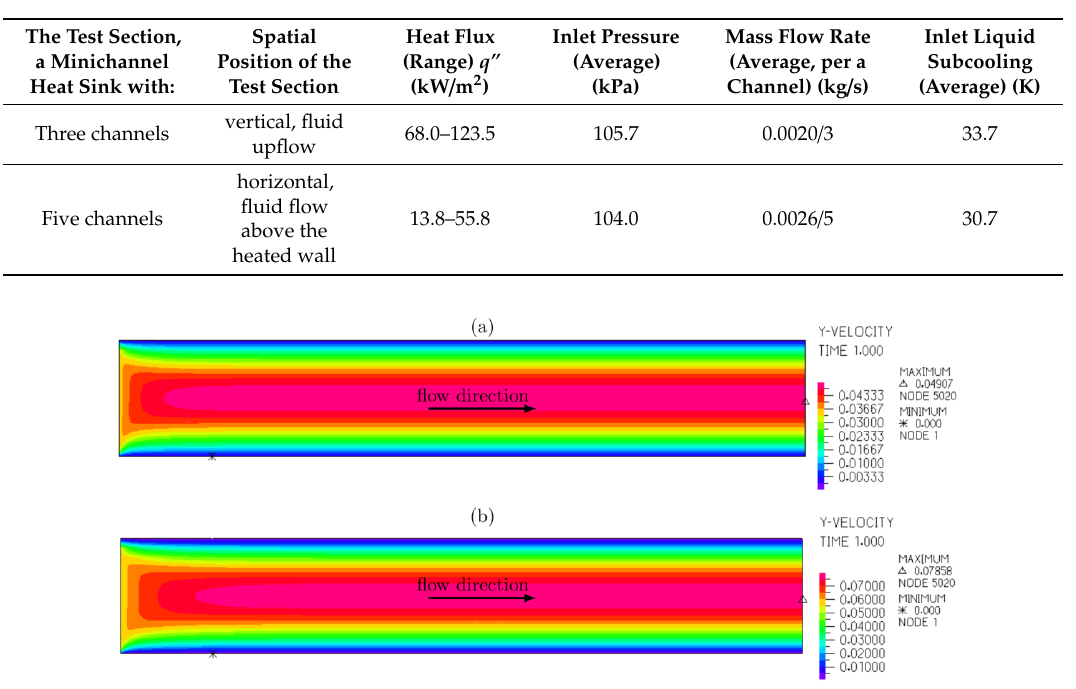
Figure 7. Distribution of y -component of fluid velocity obtained from the FEM computations carried out by ADINA software: ( a ) the test section with three minichannels, q’’ = 68 kW/m 2 ; ( b ) the test section with five minichannels, q’’ = 13.8 kW/m 2 ; other experimental parameters are listed in Table 2.